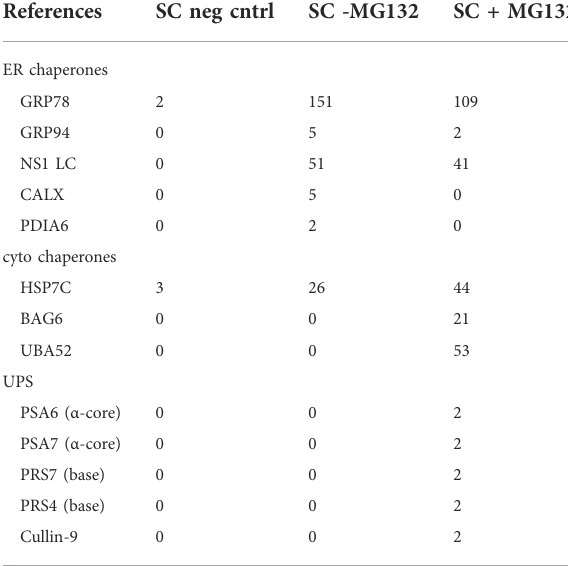
TABLE 2 Identi fi cation of proteins associated with